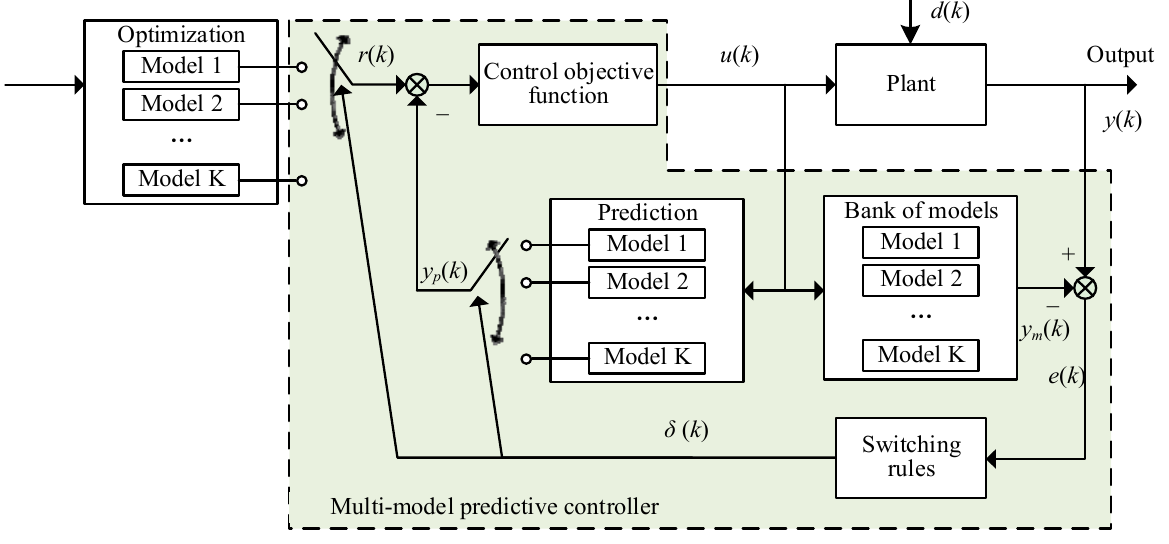
Figure 10. The structure of the multi-model predictive controller for the direct air-cooling condenser.